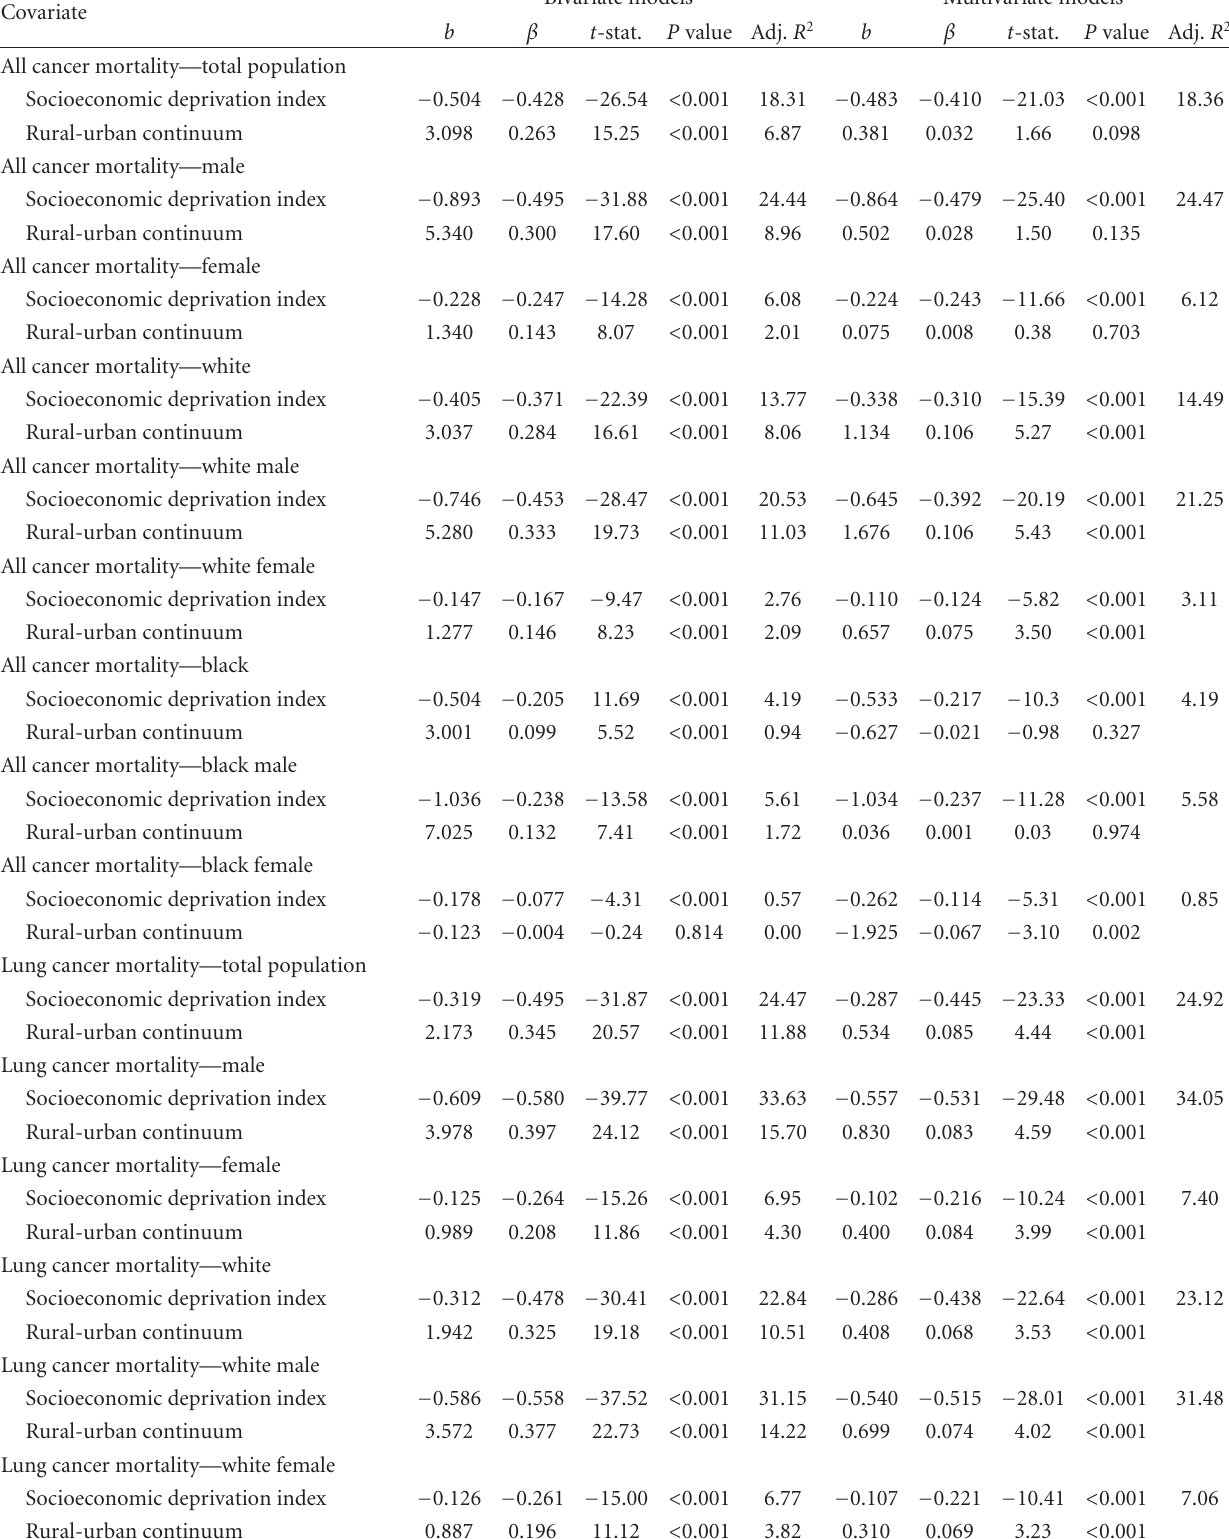
Table 3: Weighted least squares regression models 1 showing the relative impacts of the continuous socioeconomic deprivation index 2 and rural-urban continuum 3 on county-level age-adjusted mortality rates for all cancers combined and lung cancer, United States, 2003–2007 ( N =